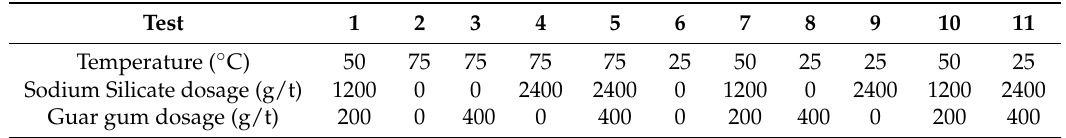
Table 4. Factorial design test